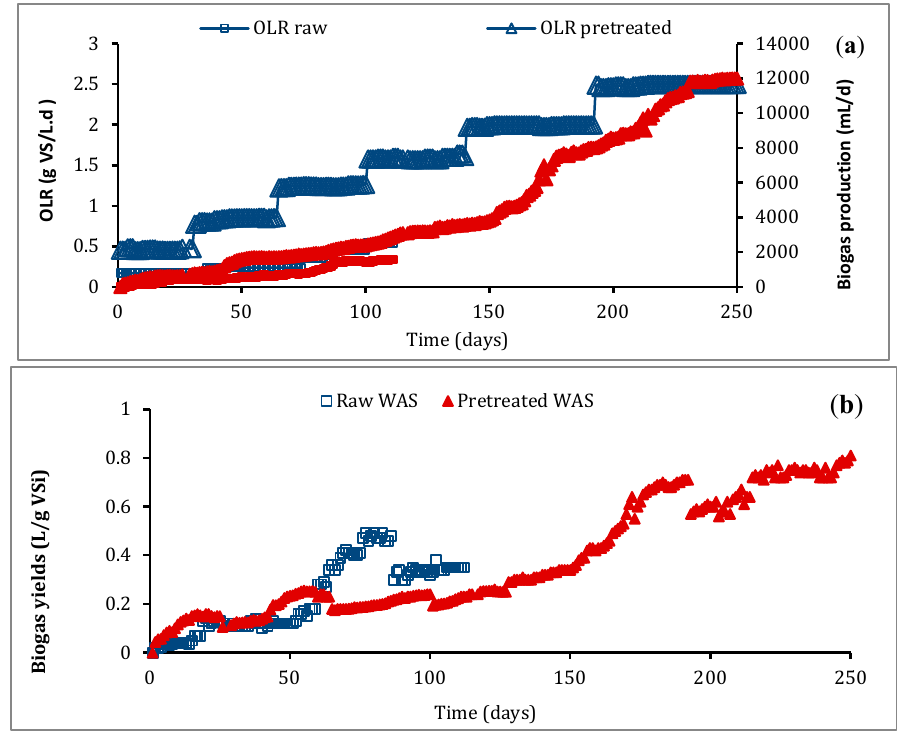
Figure 4. Evolution of organic loading rate ( a ) and biogas yield ( b ) during semi-continuous fermentation of raw and pretreated sludge in an up-flow anaerobic sludge blanket reactor.